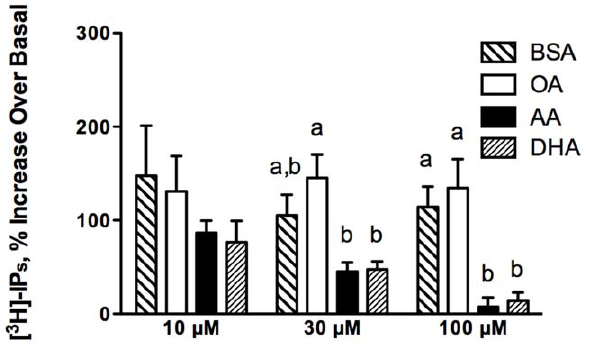
Figure 5. Internalized [ 3 H]-oxytocin in PHM1-41 cells. Data are expressed as a percent of total cell-associated ligand (membrane bound + internalized). Values are mean 6 SEM (n=3 experiments). Points not sharing common letters are significantly different between treatment groups, p , 0.05.